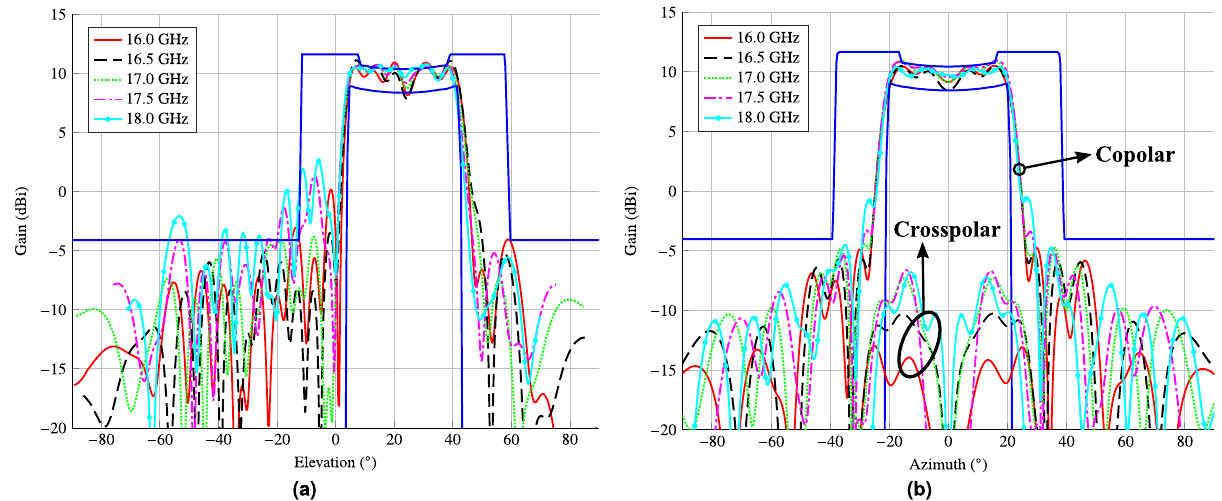
Figure 10. Main cuts in ( a ) elevation and ( b ) azimuth of the design after the wideband copolar-only optimization. This design almost fulfils specifications in a 2 GHz bandwidth (11%), achieving a good trade-off between performance of a wideband shaped-beam reflectarray and its physical size. Due to the symmetry in the antenna optics, there is a null in the crosspolar pattern in the elevation cut.